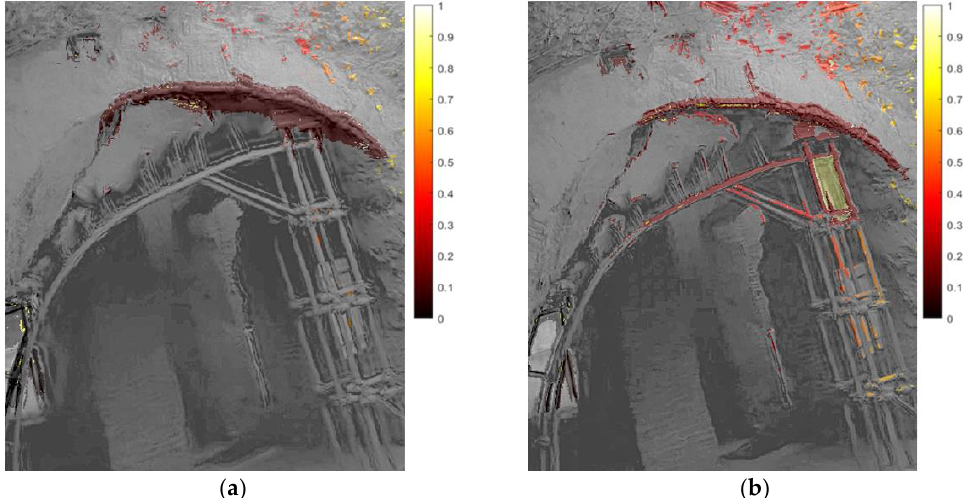
Figure 15. MM analysis of a fresco of the ruined church in the courtyard: ( a ) original frame of rec- orded video; ( b ) relative normalized displacement pattern.